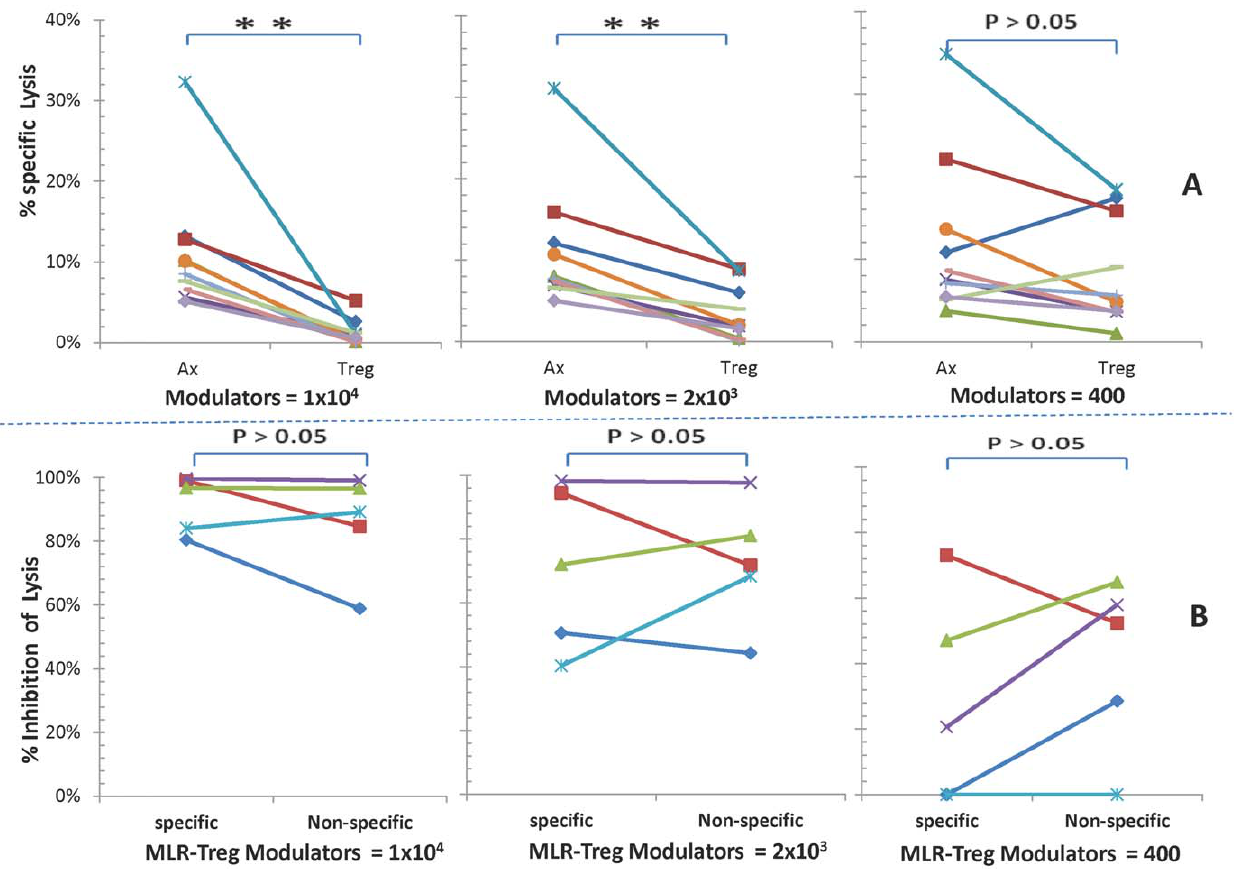
Figure 6. MLR-Tregs non-specifically regulate cytotoxic activity in micro-CML generated by purified CD8 + plus autologous non-T ‘‘APC’’ responders. Micro-CML inhibition assays were performed with purified CD8 + responders as described in Fig. 5, but in presence of non-T ‘‘APCs’’ autologous to the responders, and the data are shown as: (A) Percent specific lysis: against the specific stimulator used both in MLR-Treg generation and the micro-CML readout. The lysis of target cells was decreasingly inhibited by decreasing concentrations of modulating MLR-Tregs (points on the right side) as opposed to none seen using control (Ax) modulators (points on the left side) (**=p , .01; n=10). (B) Percentage inhibition: the percent specific lysis values were converted to percent inhibition. In contrast to the findings depicted in Figure 4B, using the original vs third party stimulating cells, inhibition of CTL activity generated by purified CD8 + plus non-T ‘‘APC’’ did not appear to be allospecific. Note the lack of significant differences between the points on the right side vs the left side of each graph in the lower row